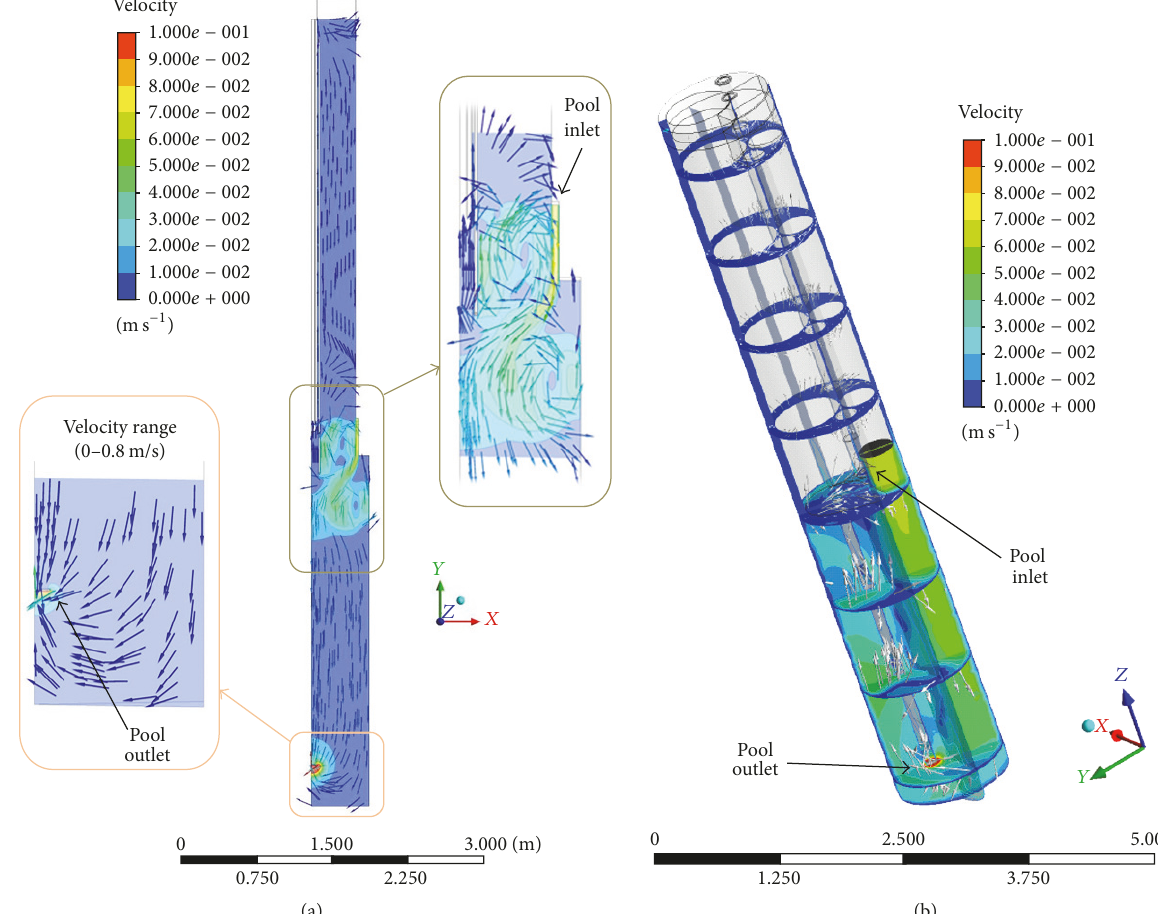
Figure 14: Velocity magnitude field in the 2D (a) and 3D (b) CFD domain of the CIRCE pool, during Step 8 of Test